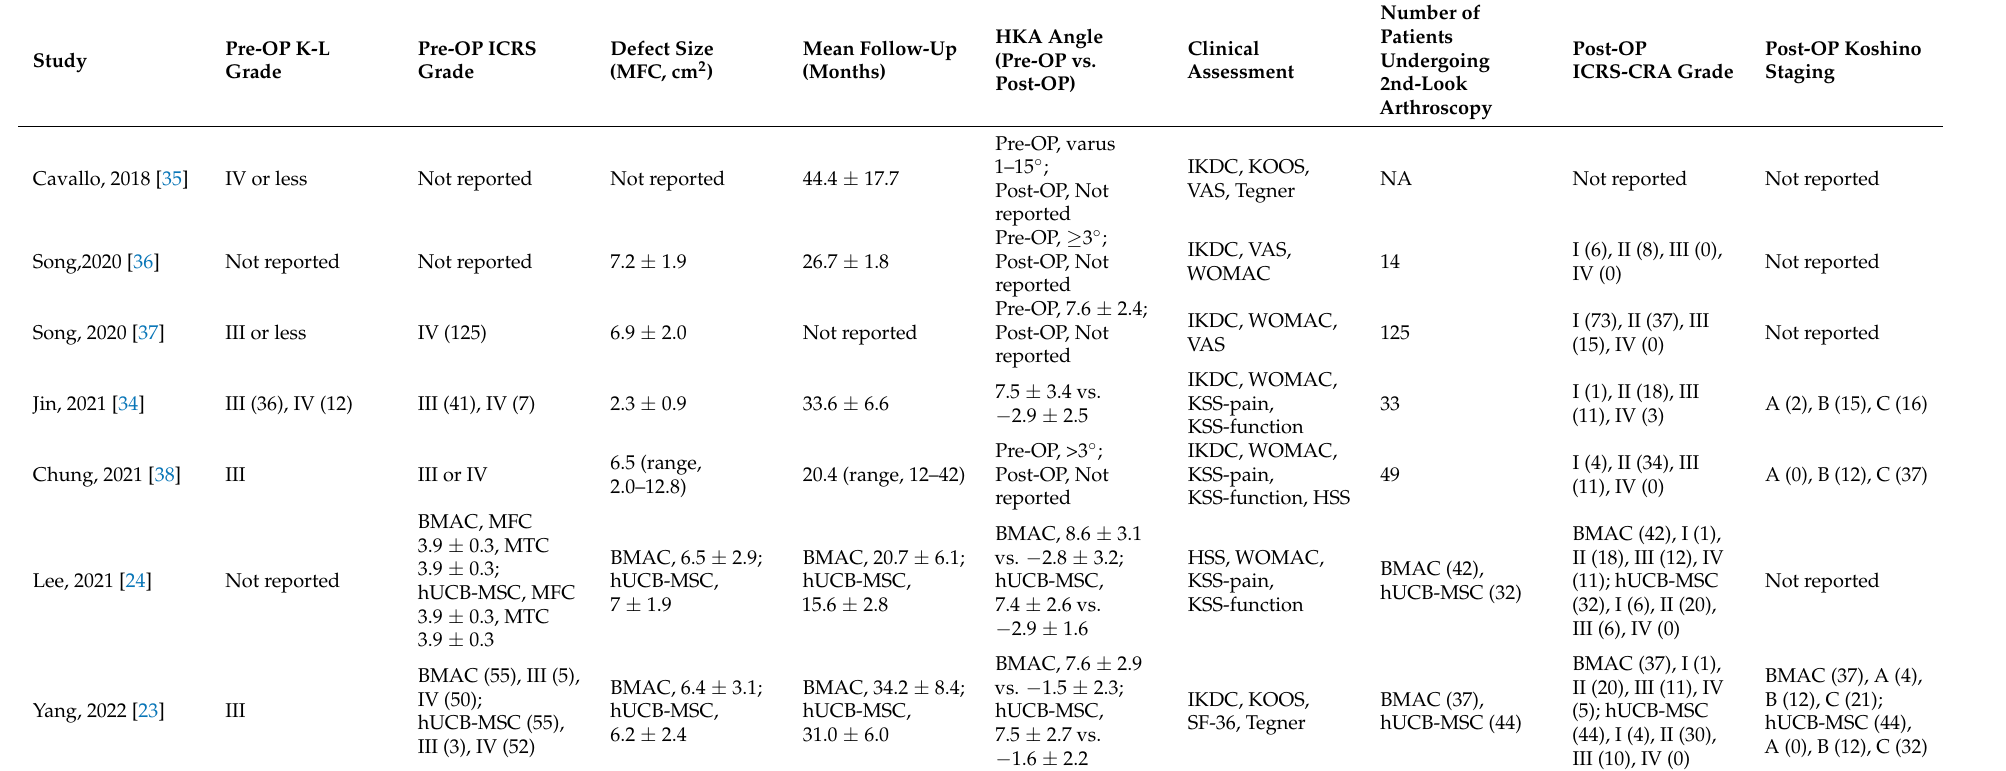
Table 2. Preoperative status and outcomes of interventions of the included